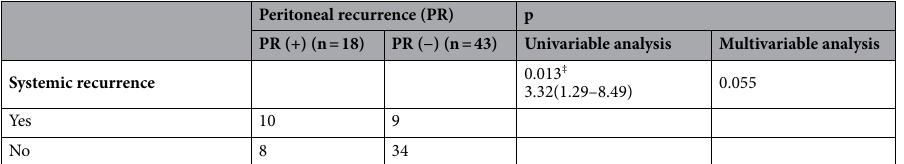
Table 4. Factors contributing to peritoneal recurrence in pT4 patients after curative resection (n = 61). IL interleukin, A ascending, T transverse, D descending, R rectum, (Q1, Q3) (first quartile, third quartile), WD well differentiated, MD moderately differentiated, PD poorly differentiated, UD undifferentiated, Muc mucinous. *Age and BMI had normal distribution (p > 0.05, Shapiro–Wilk test) but tumor size did not. (p < 0.05 in PR(-)). † The cut-off value obtained using the maximum value of Youden’s index (sensitivity = 0.889, specificity = 0.628). ‡ p < 0.1, Univariable Cox regression. § p < 0.05, Multivariable Cox regression. ¶ Conversion cases from laparoscopic to open surgeries were included. **Cox regression with Firth’s correction. †† Data from two patients were missed in BMI and four data were missed in